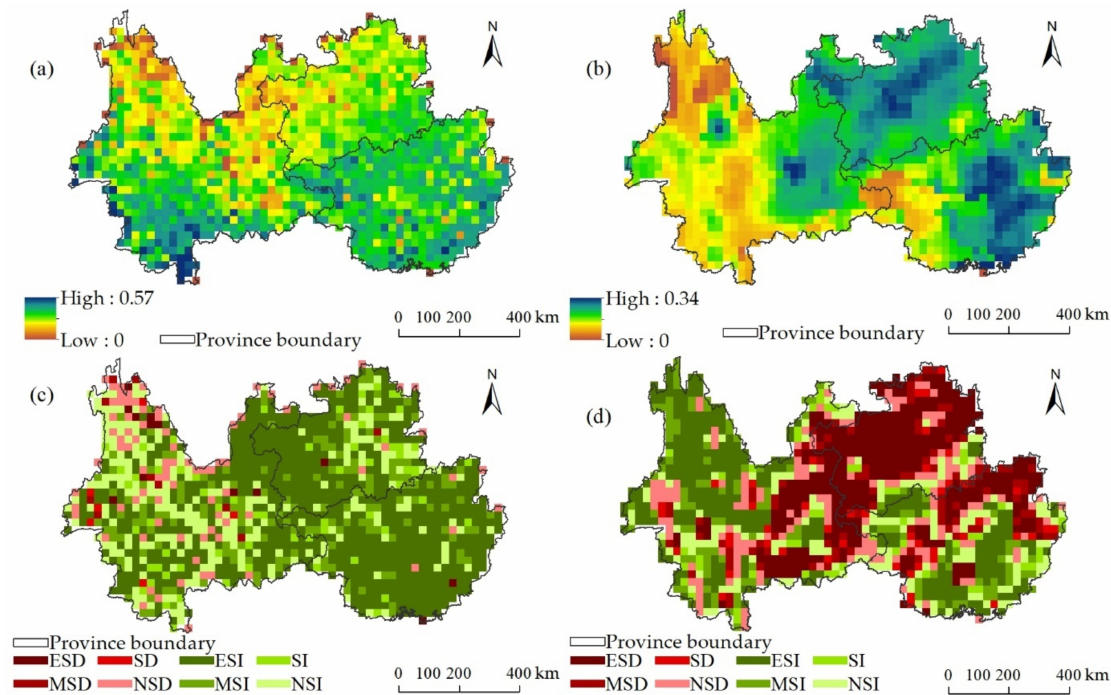
Figure 4. Distribution of ( a ) the annual average EVI/( b ) soil moisture content (cm3/cm3) and ( c ) multiyear temporal variation trend of annual EVI/( d ) soil moisture content in the humid karst areas during 2002–2018 (ESD represents extremely significant decrease; MSD represents more significant decrease; SD represents significant decrease; NSD represents nonsignificant decrease; ESI represents extremely significant increase; MSI represents more significant increase; SI represents significant increase; NSI represents nonsignificant increase, more detailed description of the classes can be found in Table 2). Table 4. The area and proportion of soil moisture content and EVI changes in the humid karst areas during 2002–2018. Variation